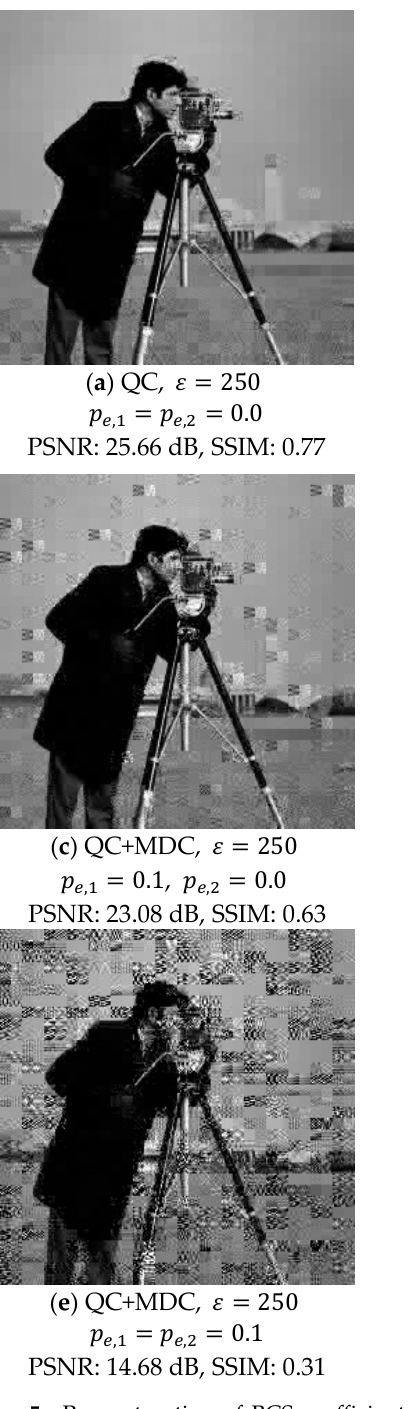
Figure 5. Reconstruction of BCS coefficients with quadratic constraint (QC) over lossy channels with protection.